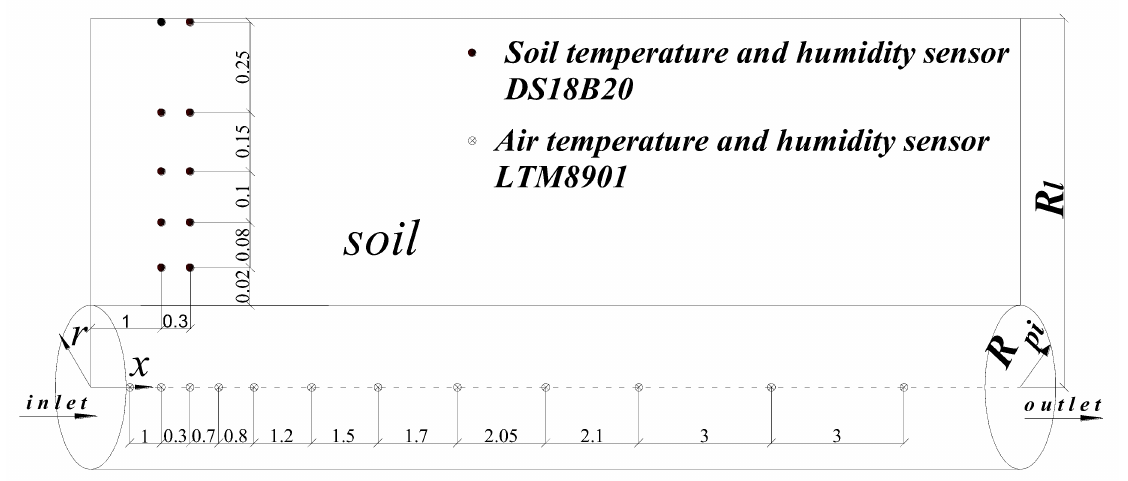
Figure 6. The experimental set up of the EAHE in this